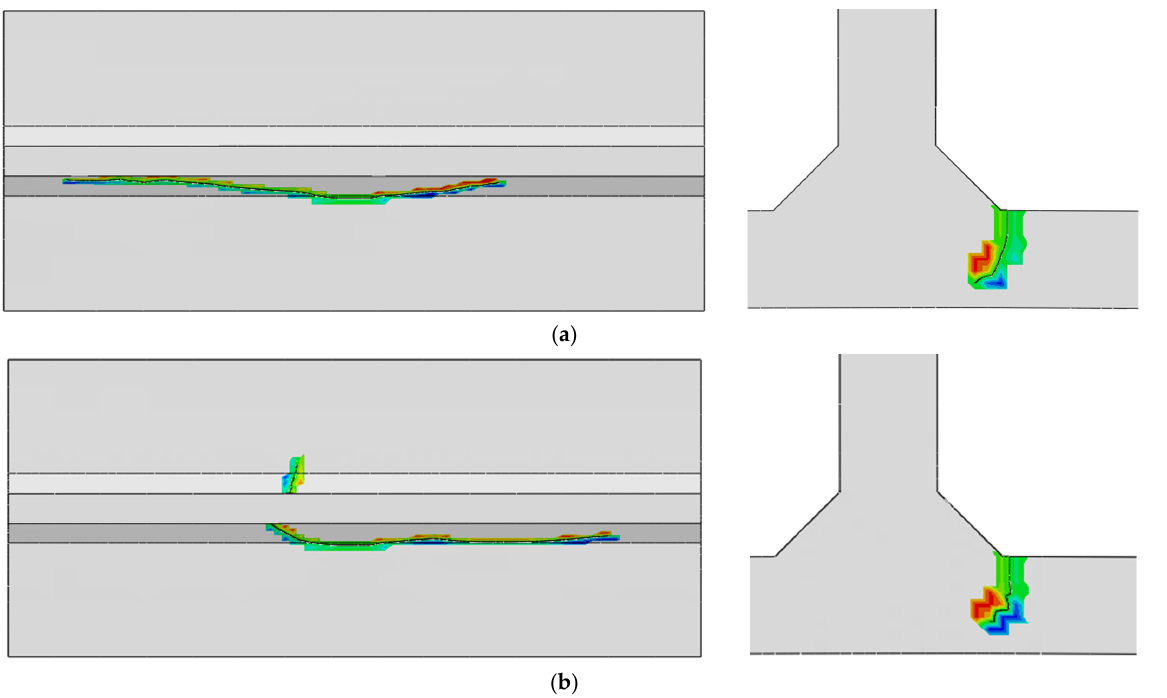
Figure 18. Crack propagation under a maximum displacement of 0.5 mm: ( a ) without residual stress field at 14,653 cycles; ( b ) with residual stress field at 37 cycles.